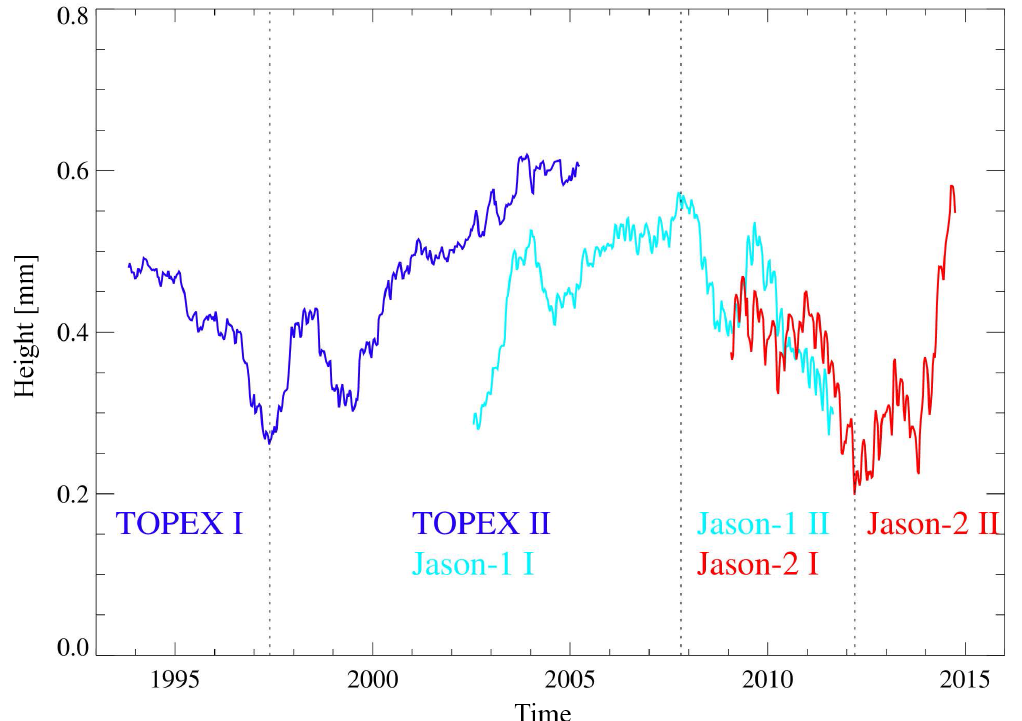
Figure 7. Mean radial height differences (VER11-VER13) over the global ocean low pass filtered by 1-year boxcar filter for TOPEX (blue), Jason-1 (cyan), and Jason-2 (red). The sub-periods used for the calculation of trends are marked by dashed lines.